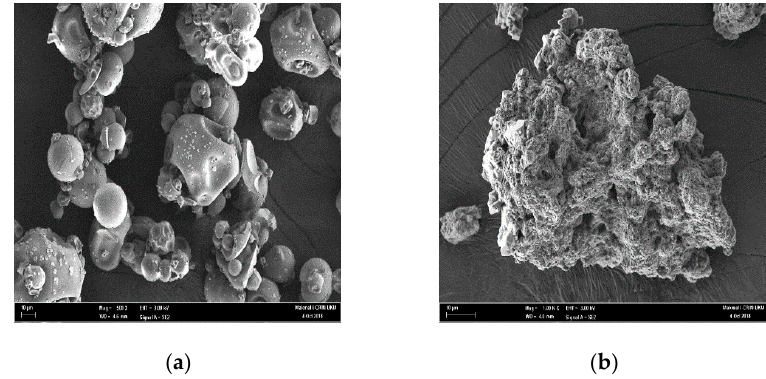
Figure 4. Microscopic image (10 µm) for tannin ( a ) before ( b ) after coagulation process observed by scanning electron microscopy.